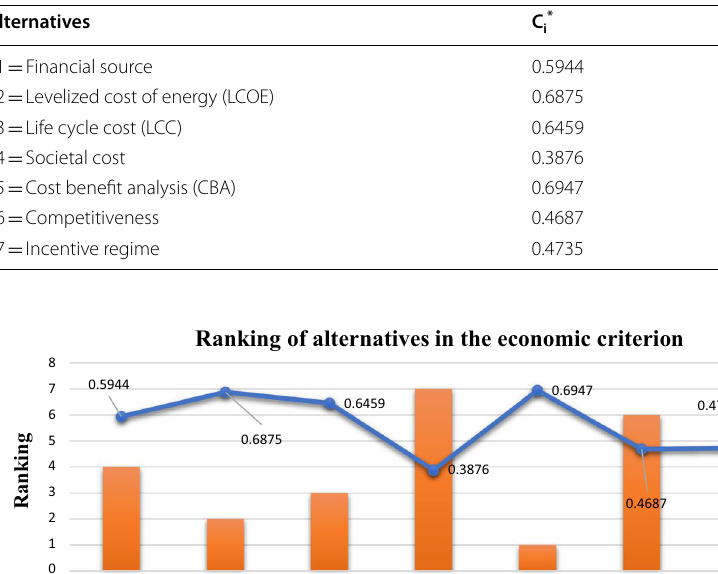
Table 24 Ranking of alternatives in Economic criterion